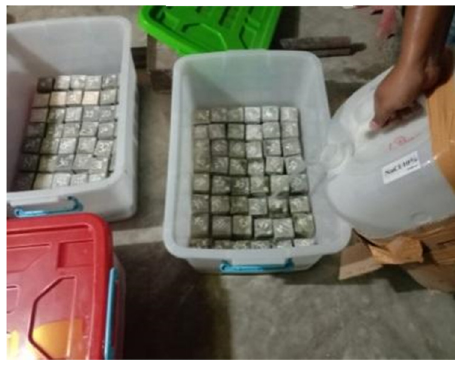
Figure 7: The specimens exposed to NaCl and Na 2 SO 4 solution.